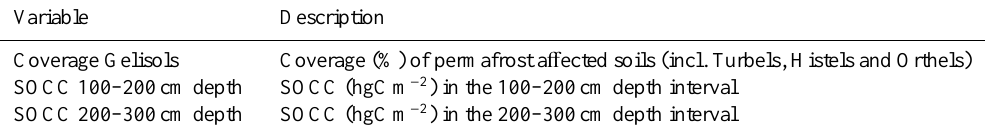
Table 3. Description of the NCSCDv2 variables that have been converted to gridded file formats (TIFF-files and NetCDF-files). Each variable is stored in a separate gridded file. This table is complementary to Table 3 in Hugelius et al. (2013). This table and NCSCDv2 files uses the abbreviation SOC content (SOCC, kgCm − 2 ) following Hugelius et al.